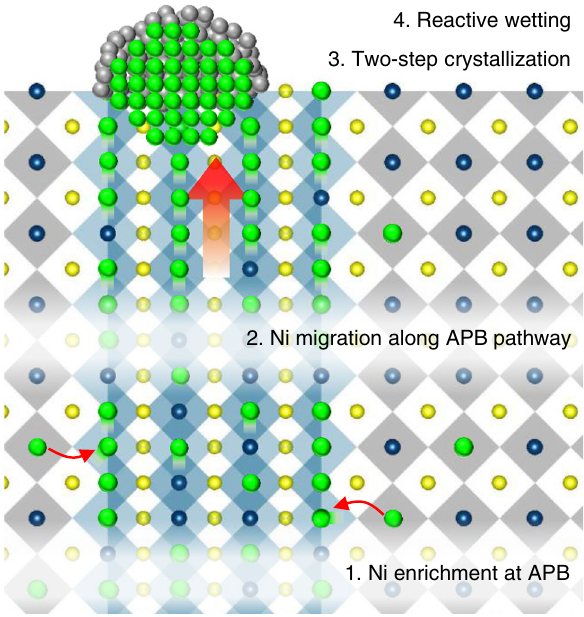
Fig. 6 | Model proposed for NP formation in a non-stoichiometric perovskite oxide based on in situ STEM observations and DFT calculations. The APB pre- sents a low energy segregation site and also fast diffusion pathway for exsolved Ni toward surface. The formation of Ni NP occurs via two step crystallization. The reactive wetting of Ni NP with oxide results in the formation of ridge at the triple junction, leadingto thestronganchoringof Nitothe oxide.Theyellow,green,and navyspheresdenoteLa/Sr(A-site),Ni(B-site),andTi(B-site)ions,respectively.The gray and green spheres on the surface represent the amorphous and crystalline Ni atoms, respectively. The gray octahedra represent the core-shared network in the